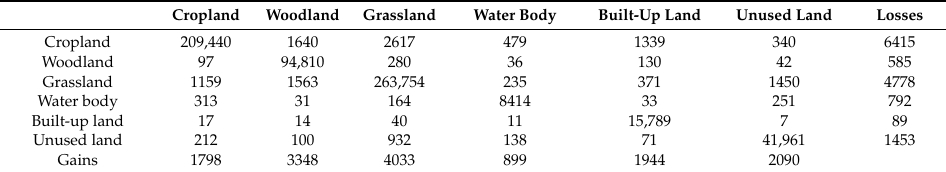
Table 2. Transition matrix of LULCC in the Loess Plateau between 2000 and 2010 (Unit: km 2 ). Cropland Woodland Grassland Water Body